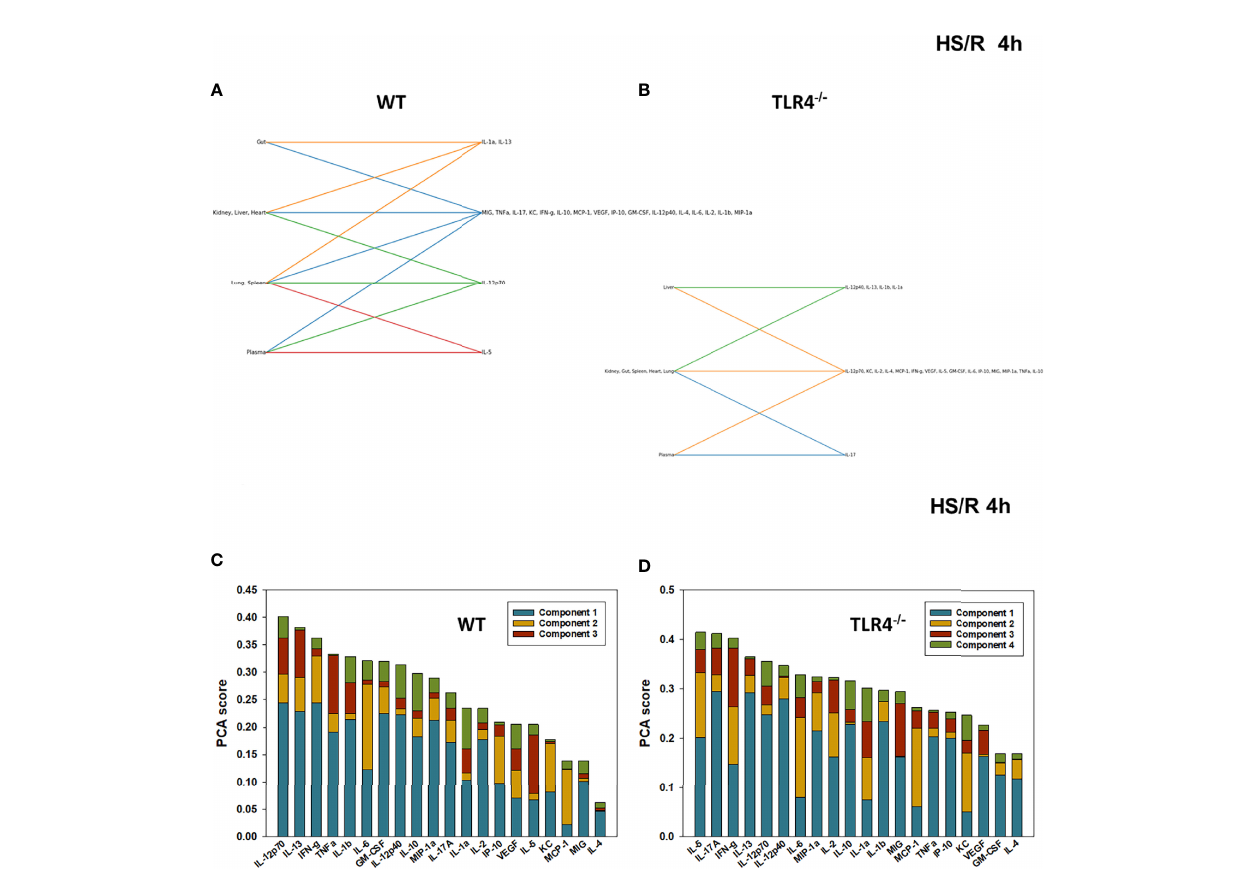
FIGURE 6 | Hypergraphs and Principal Component Analysis of in fl ammatory mediators from WT and TLR4 -/- mice subjected to HS/R (4h). Plasma and tissue samples from heart, lung, liver, gut, spleen, and kidney were collected from WT and TLR4 -/- mice subjected to HS/R (4h) and analyzed using Luminex ™ as described in Materials and Methods. Panels (A, B) show the hypergraphs and Panels (C, D) show the PCA results (70% variance) in WT and TLR4 -/- mice,